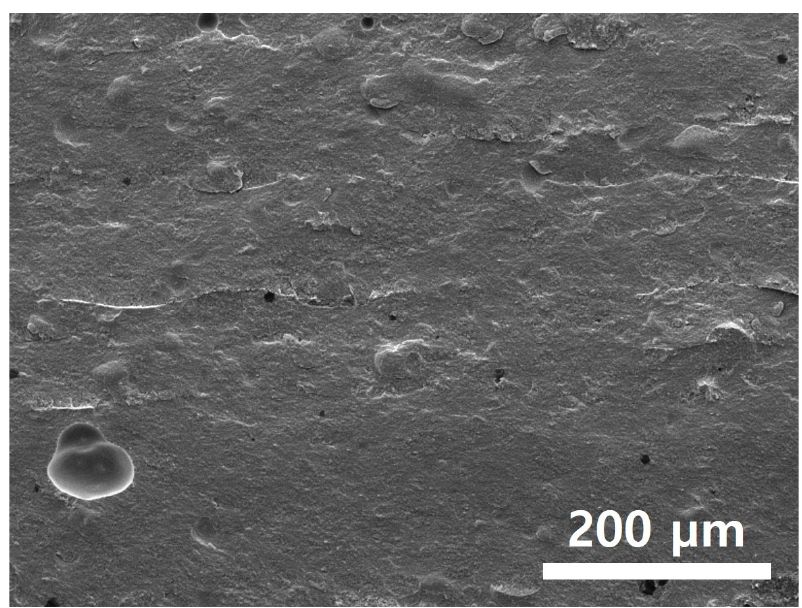
Figure 19. Cross-sectional SEM image of micro square pattern.